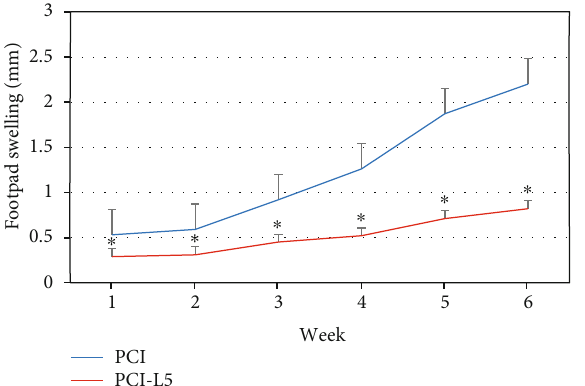
Figure 5: Footpad swelling in BALB/c mice immunized intramuscularly in the left posterior thigh muscle 3 times at 2-week intervals, with 100 μ g of empty plasmid as the control group pCI and 100 μ g of pCI-L5 vaccine as the study group pCI-L5. After challenge in the right footpad with 10 6 Leishmania tropica promastigotes 2 weeks after the last immunization. As geometric mean ± SD . ∗ P < 0 : 05 , signi fi cant increase in footpad swelling in the vaccinated group compared to the control